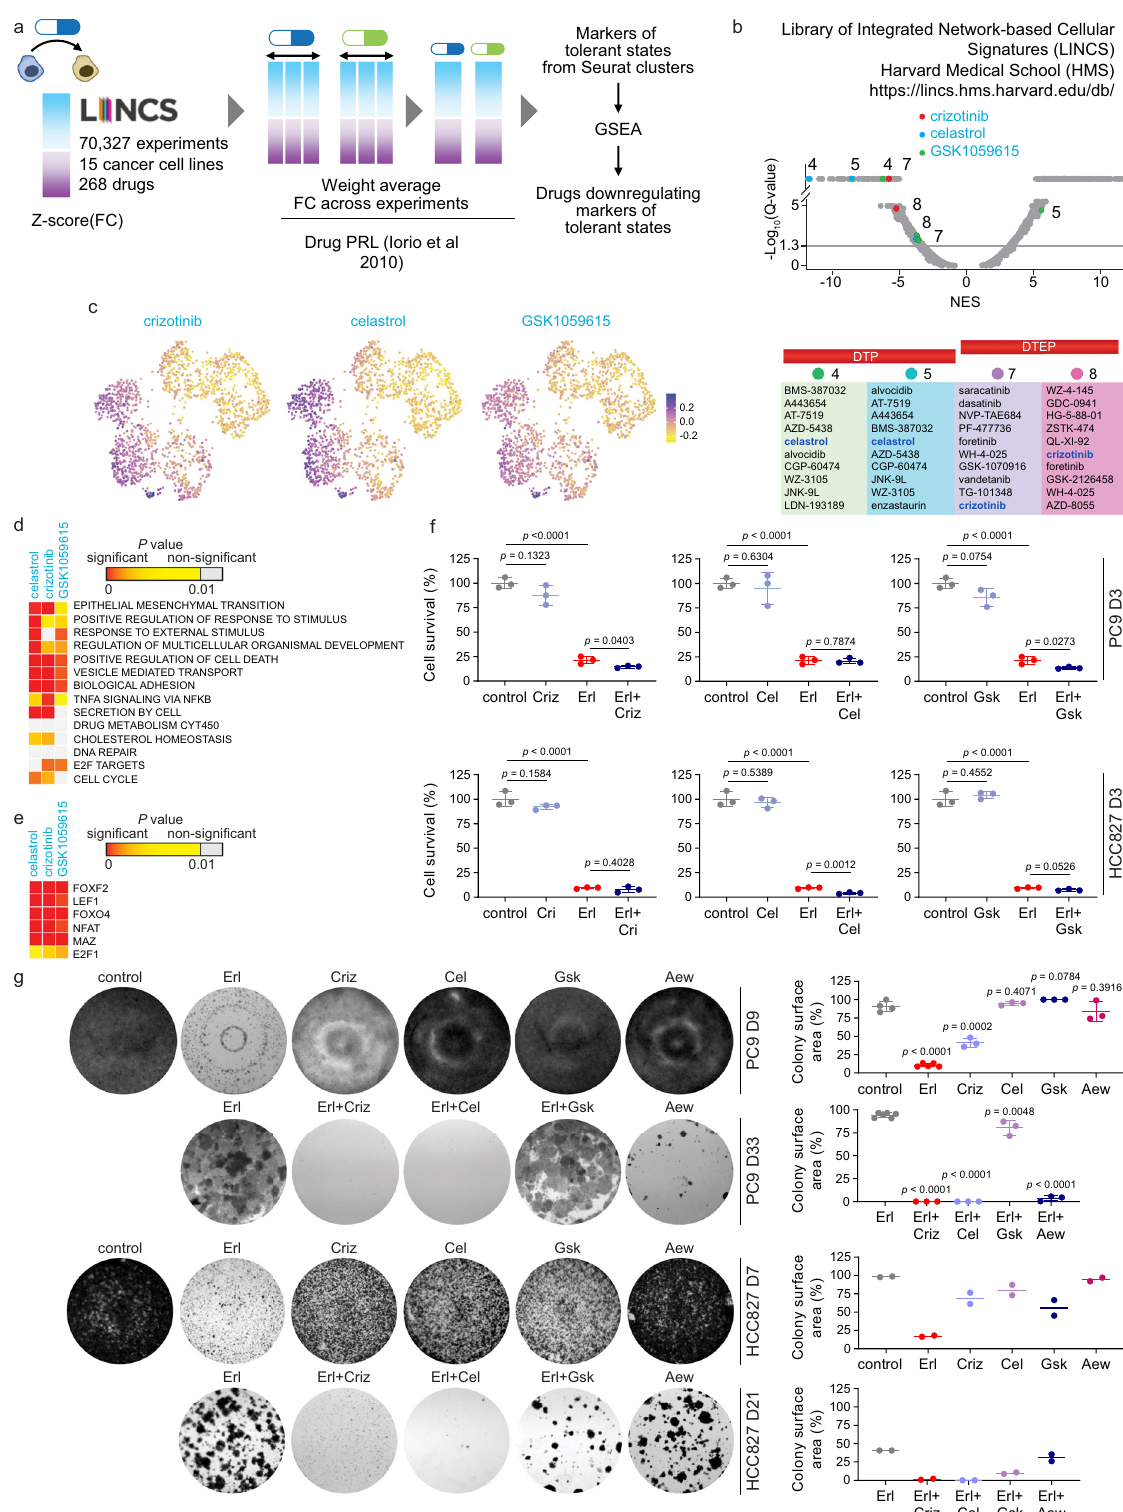
inhibitor. Most EGFR-TKI acquired resistant tumors display MET activation, which occurs via increased transcription and protein expression of MET . Our identi fi cation of crizotinib was highly relevant because previous compound screenings showed that the EGFR/MET inhibitor combination was effective for eliminating resistant cells 39 . HCC827 cells have ampli fi cation